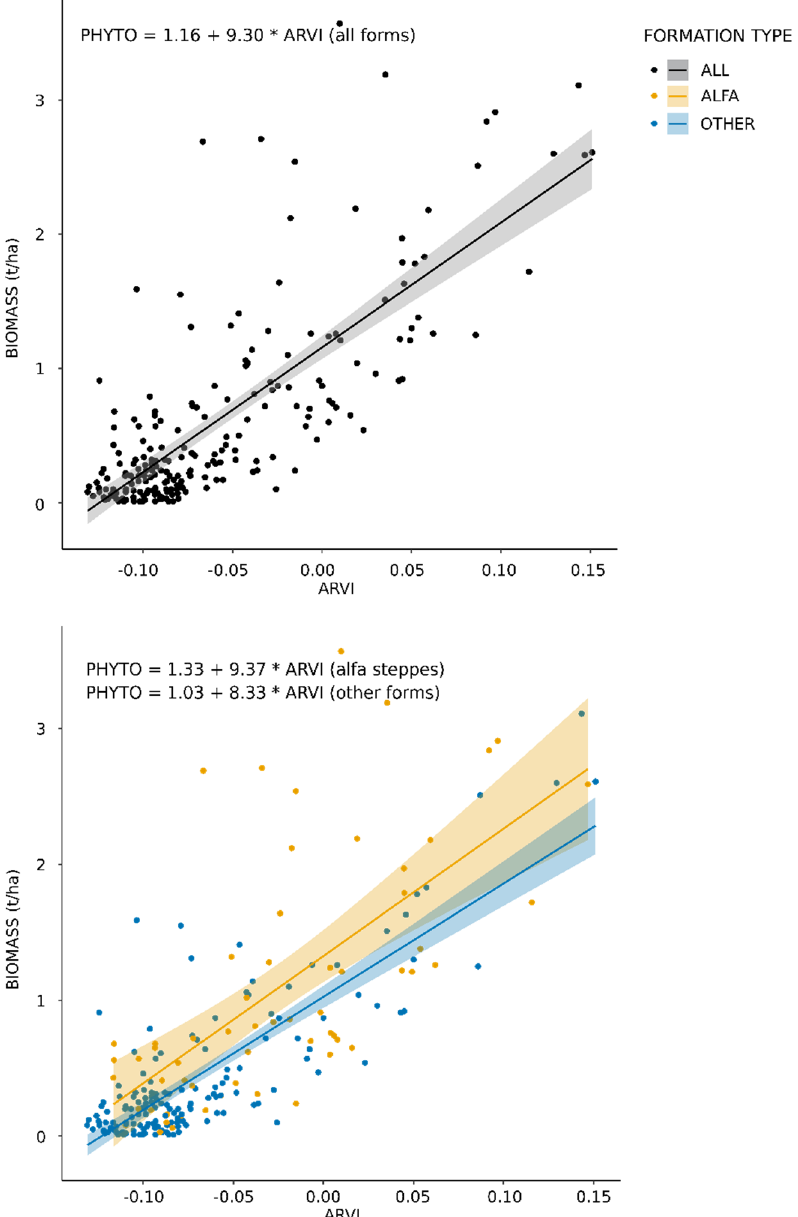
Figure 6. Comparison of the linear relation between biomass and ARVI for the overall case (top) and alfa steppes vs. other types of vegetation formation (bottom). Solid and dashed lines = linear regression, grey/color area = 95% confidence interval on the regression line. (See Figure S5 for a black and white version.). Table 6. Performance metrics of the linear models for the different types of vegetation formations.